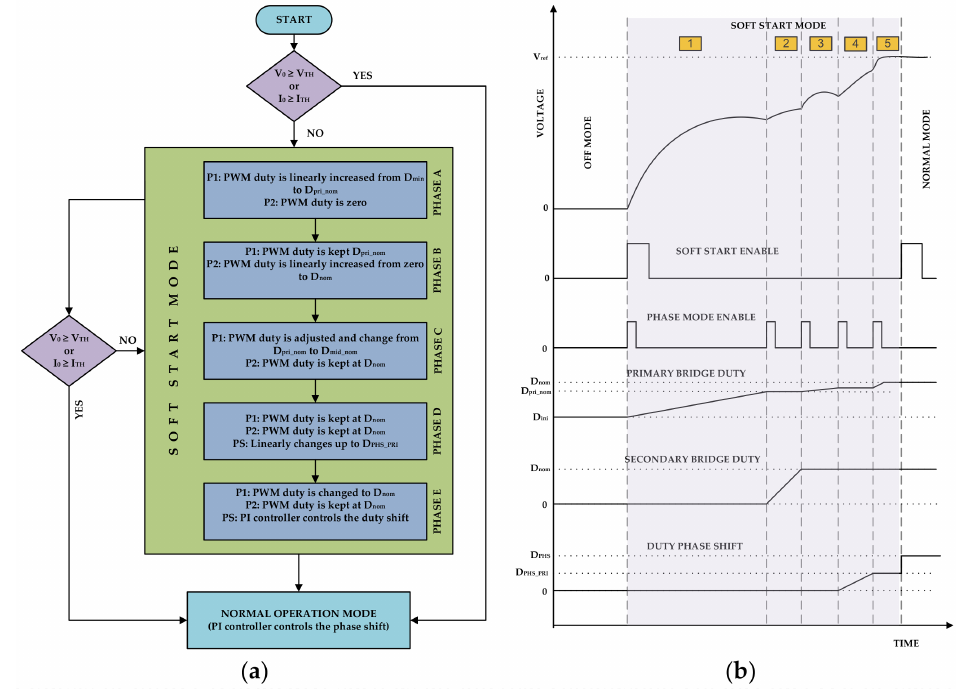
Figure 11. Five phase soft-start algorithm ( a ) Flow chart ( b ) timing